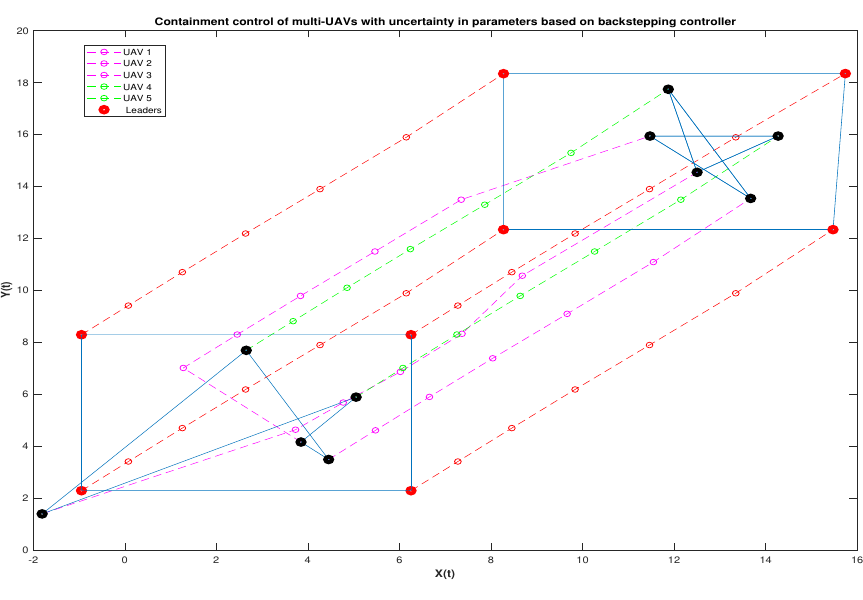
Figure 12. Map of UAVs containment based on backstepping control with parameters